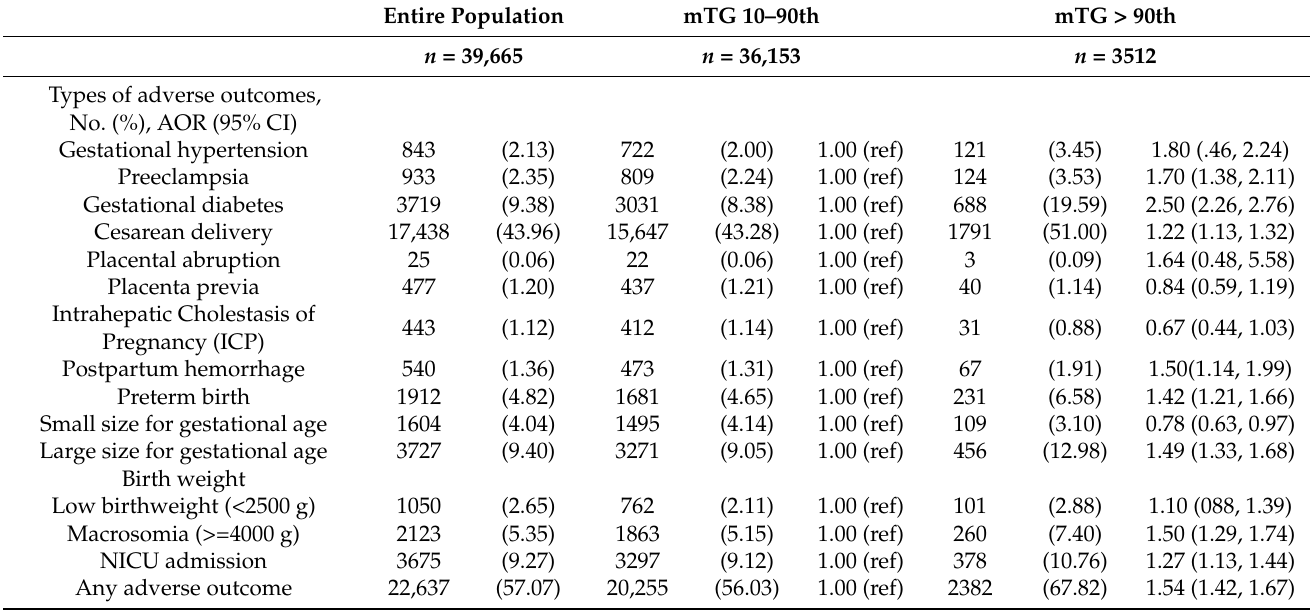
Table 2. Maternal TG in early pregnancy and risks of adverse pregnancy outcomes. Entire Population mTG